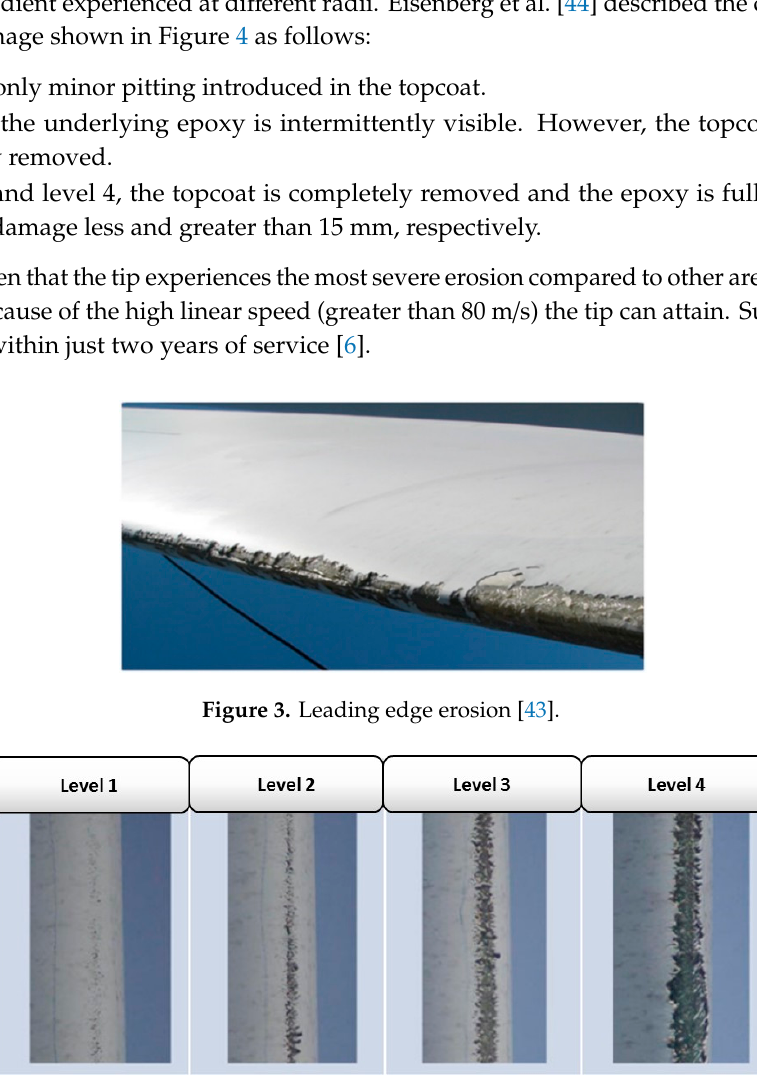
Figure 4. Level of erosion damage experienced at different radii. Adapted from [44].